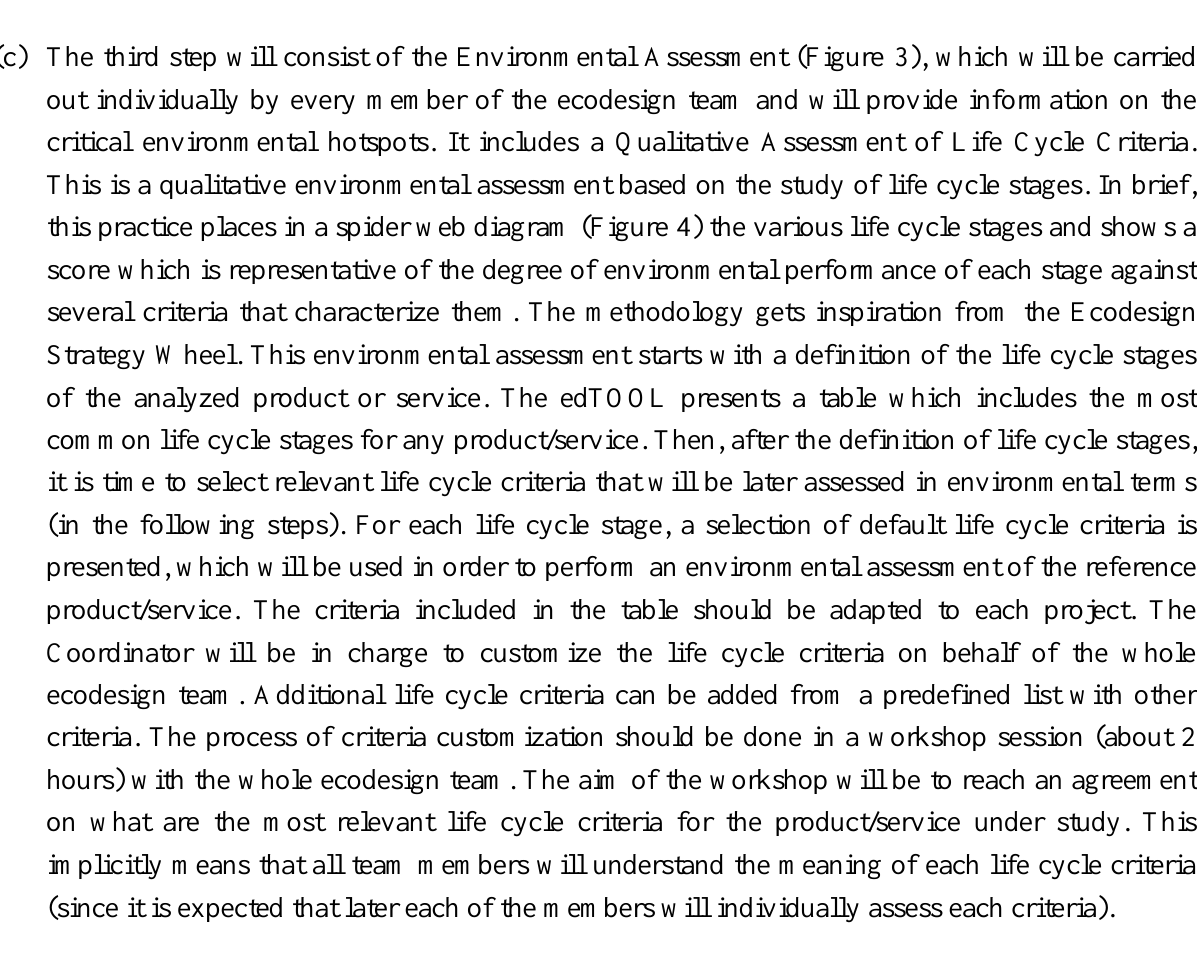
Figure 3. Methodology scheme of the